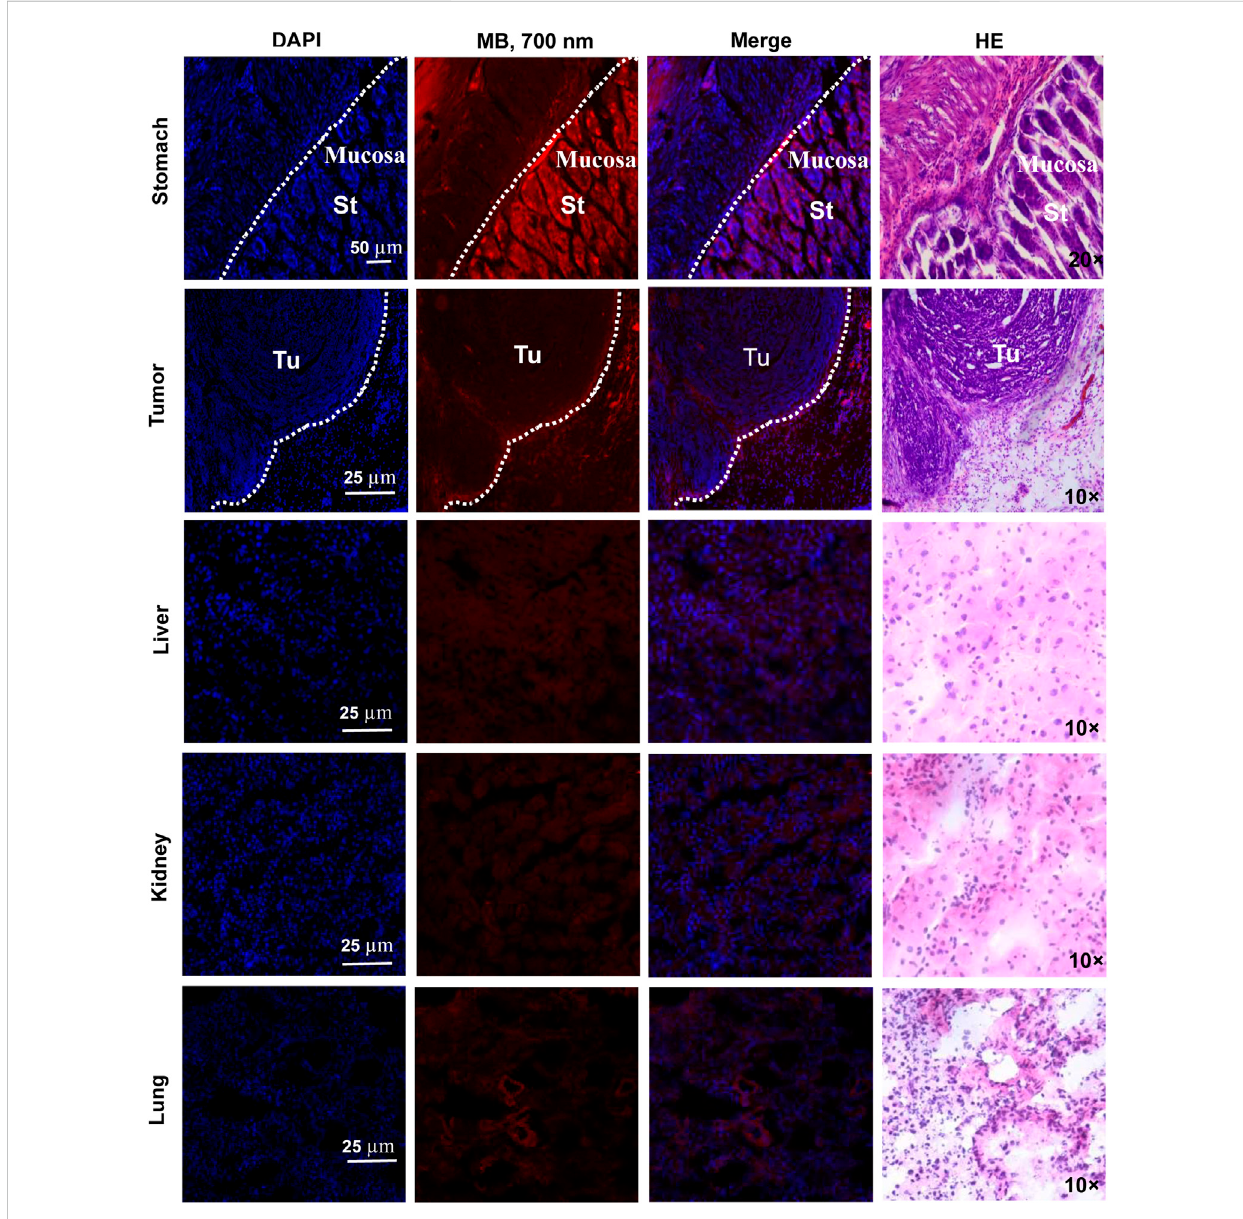
FIGURE 9 Fluorescence imaging and pathological analysis of MB. MB was injected intravenously into subcutaneous gastric tumor-bearing nude mice 72 h before resection. Then NIR fl uorescence and HE staining of the organs (stomach, tumor, liver, kidney, and lung) were imaged under the confocal microscope and Nikon 50i microscope. Abbreviations are St, stomach; Tu,